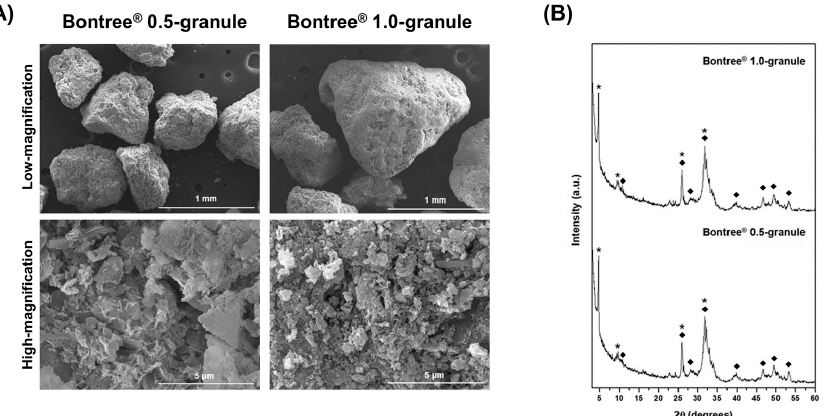
Figure 1. ( A ) Representative low- and high-magnification FE-SEM images of the Bontree ® granules: Bontree ® 0.5-granule and Bontree ® 1.0-granule refer to Bontree ® granules with diameters of 0.5 mm and 1.0 mm, respectively. ( B ) The XRD spectra of the Bontree ® 0.5-granule and Bontree ® 1.0-granule. The OCP and HA peaks are indicated by * and ◆ , respectively. FE-SEM, field-emission scanning electron microscopy; XRD, X-ray diffraction; OCP, octacalcium phosphate; HA, hydroxyapatite. 3.1.2. In Vitro Study The RANKL and ALP activities of the MG63 cells were assessed using ELISA to as- sess the role of Bontree ® in bone formation and remodeling (Figure 2A,B). For comparison, a commercial biphasic calcium phosphate ceramic (MBCP+ TM ) was also assessed as a ref- erence [17]. Prior to in vitro testing, each specimen was compressed into tablets. Bontree ® refers to both Bontree ® 0.5-granule and Bontree ® 1.0-granule samples. The level of RANKL, an osteoclast differentiation factor [18], was lower in cultures with Bontree ® than in those with MBCP+ TM during both culturing periods; it was 11.3 ng/mL and 19.0 ng/mL for Bontree ® and 14.1 ng/mL and 28.6 ng/mL for MBCP+ TM after 7 and 14 days, respectively. In contrast, the activity of ALP, an osteoblast differentiation marker [19], was significantly elevated in cultures with Bontree ® (17.9 ng/mL and 22.4 ng/mL at 7 and 14 days, respectively), showing 1.9- and 1.6-fold higher values than in cultures with MBCP+ TM (9.2 ng/mL and 13.9 ng/mL at 7 and 14 days, respectively).